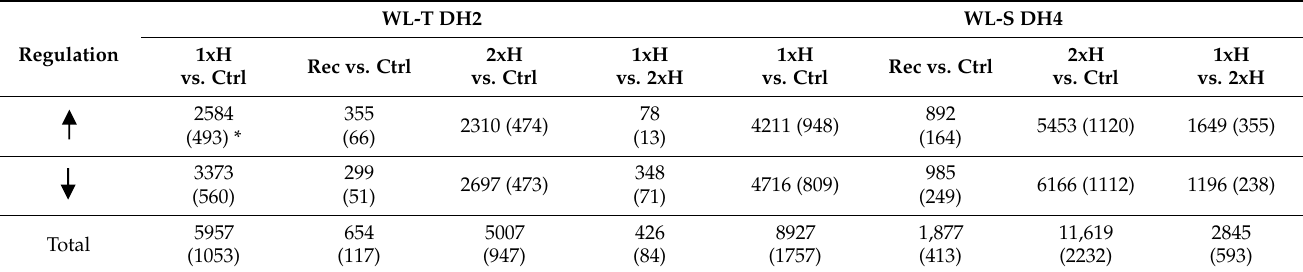
Table 2. Numbers of differentially expressed genes (DEGs).